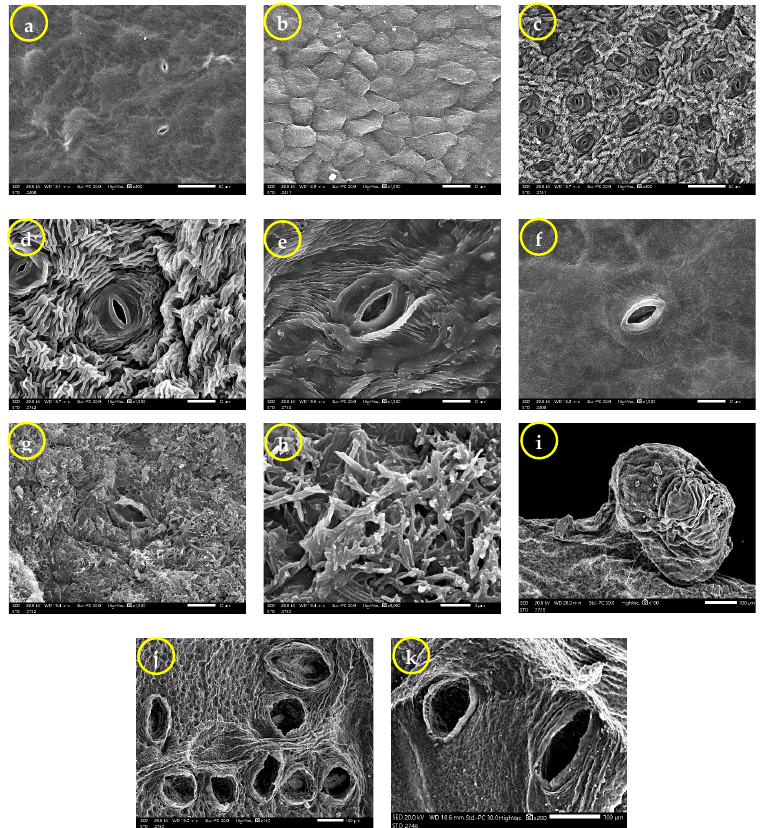
Figure 5. Scanning electron microscope (SEM) photomicrographs of Ricinus communis leaf surfaces. ( a , c ) General view showing the epidermal cell outline, anticlinal wall, and curvature of the outer periclinal wall. ( d – f ) Showing the striation density of the fine relief of the periclinal wall: ( d ) dense, ( e ) moderate, ( f ) sparse. ( g , h ) Rodlets of epicuticular crystalloid wax. ( i – k ) Anomalous stomata. Abaxial leaf surface ( a , f – i ). Adaxial leaf surface ( b – e , j , k ). Scale bar = 100 µ m (i–k); 50 µ m ( a , c ); 10 µ m ( b , d – g ); 2 µ m ( h